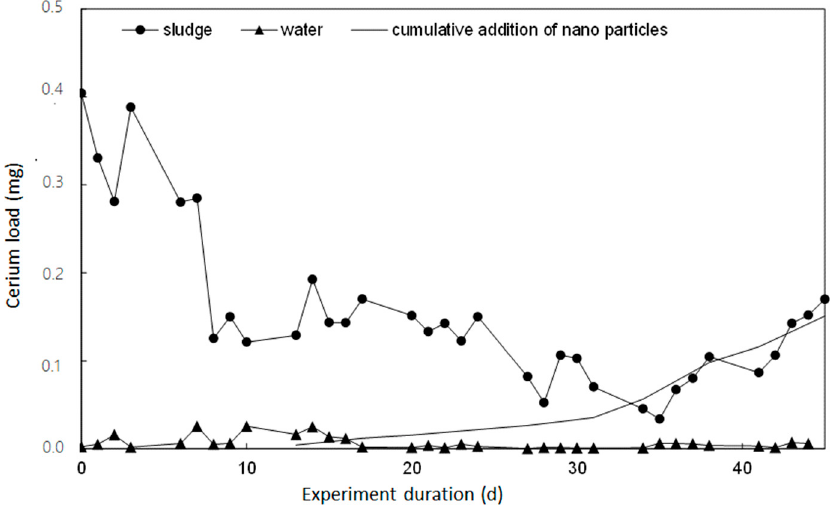
Figure 6. Discharge loads of cerium NP after continuous particle addition.